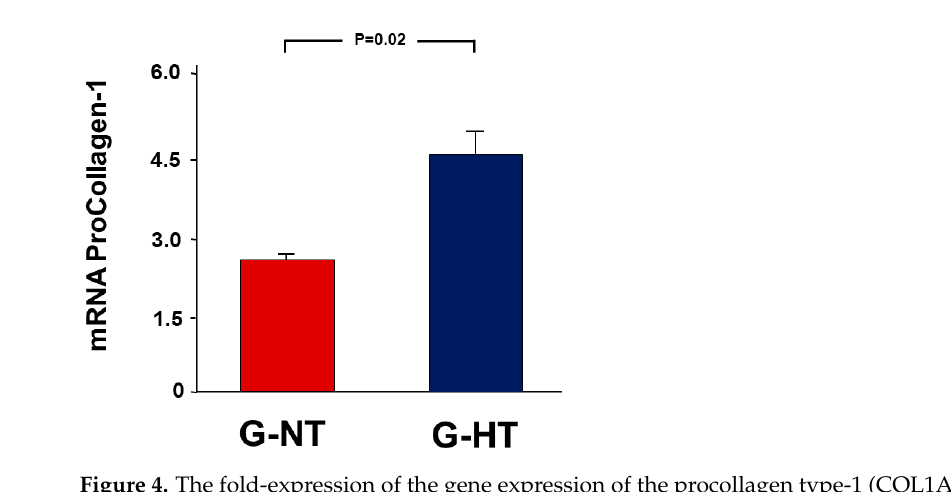
Figure 4. The fold-expression of the gene expression of the procollagen type-1 (COL1A) (G) in the POK (post-obstructed kidney) compared with the NOK (non-obstructed control kidney) within each group. Values represent the mean ± SEM. Figure 4. The fold ‐ expression of the gene expression of the procollagen type ‐ 1 (COL1A) (G) in the POK (post ‐ obstructed kidney) compared with the NOK (non ‐ obstructed control kidney) within each group. Values represent the mean ± SEM. 2.4. Western Blot Analysis As shown in Figure 5, in G ‐ NT, UUO caused a significant decrease in the expression of Bcl ‐ 2 and a significant increase in the BAX and BAX/Bcl ‐ 2 ratio. Similar trends were observed in G ‐ HT; however, the changes in all these parameters were significantly more exaggerated in G ‐ HT.